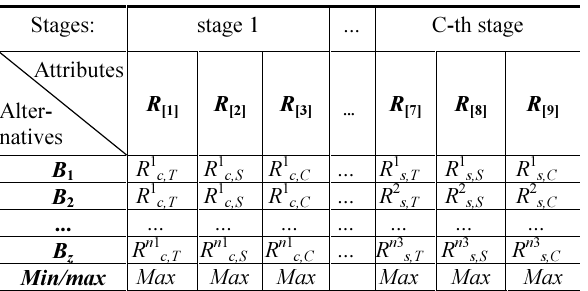
Table 1. A decision table of alternative